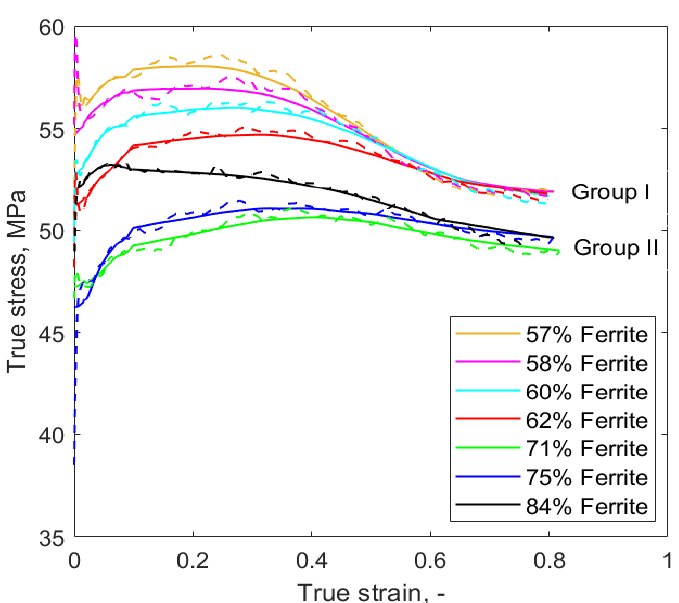
Figure 2. Microstructures after annealing at different temperatures for 1 h and quenching in water to achieve different ratios of ferrite and austenite volume fraction for ( a ) 1000 °C, ( b ) 1050 °C, ( c ) 1100 °C, ( d ) 1130 °C, ( e ) 1170 °C and ( f ) 1200 °C. Ferrite is depicted as grey and austenite as white.